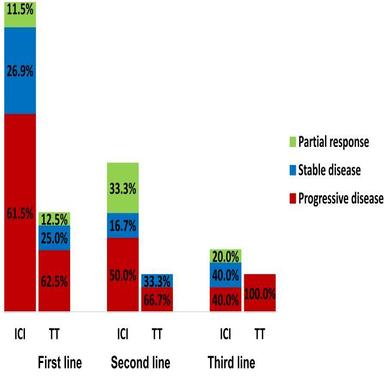
Best tumor response achieved to ICI and TT in first, second, third line. Abbreviations: ICI: Immune-checkpoint inhibition; TT: Targeted therapy.